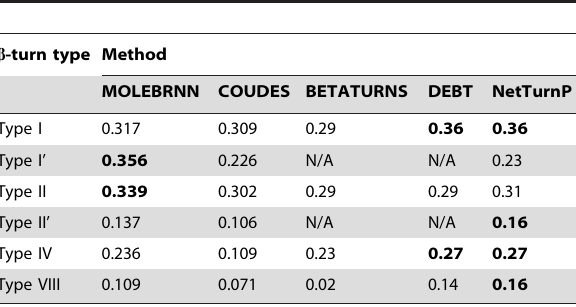
Table 2. Comparison of NetTurnP and other b -turn methods for prediction of specific b -turn types.